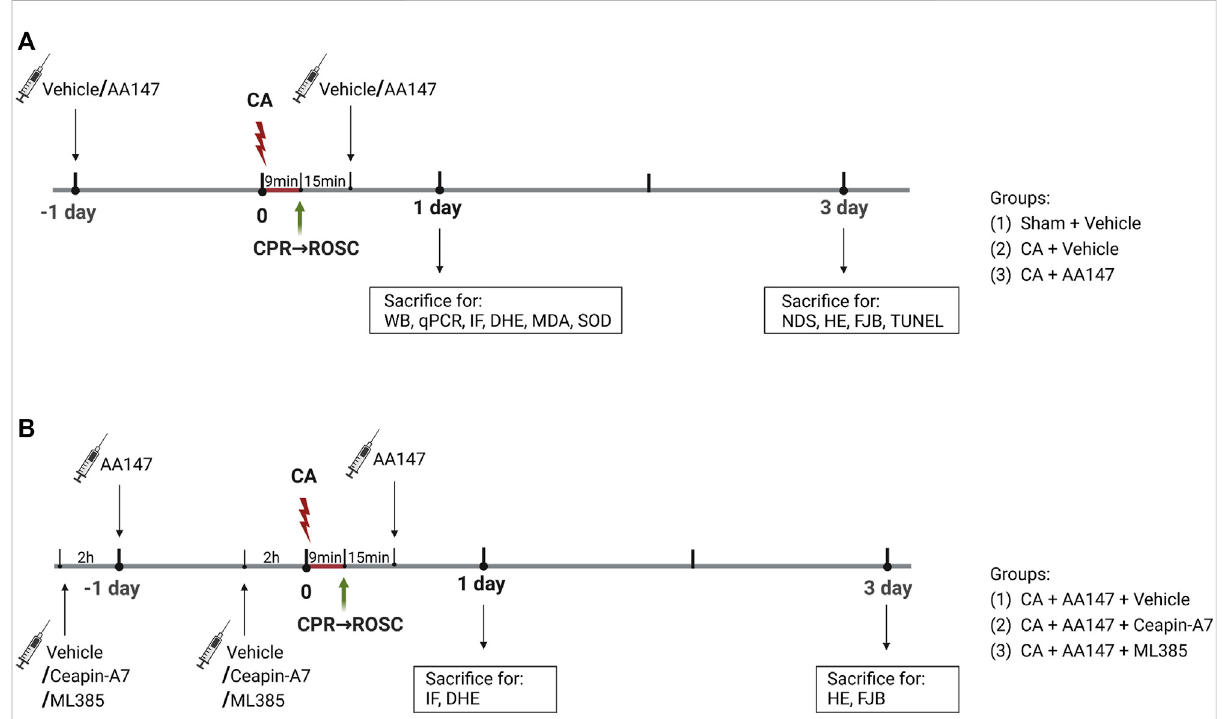
FIGURE 1 Experimental design and timeline. (A) Mice were subjected to a 9-min cardiac arrest surgery followed by cardiopulmonary resuscitation (CA/ CPR) or a sham operation. Vehicle or AA147 (ATF6 activator; 2 mg/kg) was administered intraperitoneally 1 day before surgery and intravenously 15 min after the return of spontaneous circulation (ROSC) once again. The impact of AA147 on CA/CPR-induced oxidative stress and ER stress- related apoptosis as well as activation of the ATF6 and Nrf2 signaling pathways was detected at 1 day after CA/CPR. The effect of AA147 on neuroprotection after CA/CPR was evaluated at 3 days after CA/CPR. Groups: (1) Sham + Vehicle; (2) CA/CPR + Vehicle; (3) CA/CPR + AA147. (B) Ceapin-A7(ATF6inhibitor;10 mg/kg)orML385(Nrf2inhibitor;30 mg/kg)wasadministeredintraperitoneally2 hbeforeadministrationofAA147.The role of AA147-induced activation of the ATF6 or Nrf2 in the neuroprotective effect of AA147 against post-CA/CPR cerebral ischemia/reperfusion injury wasassessedatrespective timepoint.Groups:(1)CA/CPR+ AA147 +Vehicle; (2)CA/CPR+AA147 +Ceapin-A7; (3)CA/CPR +AA147+